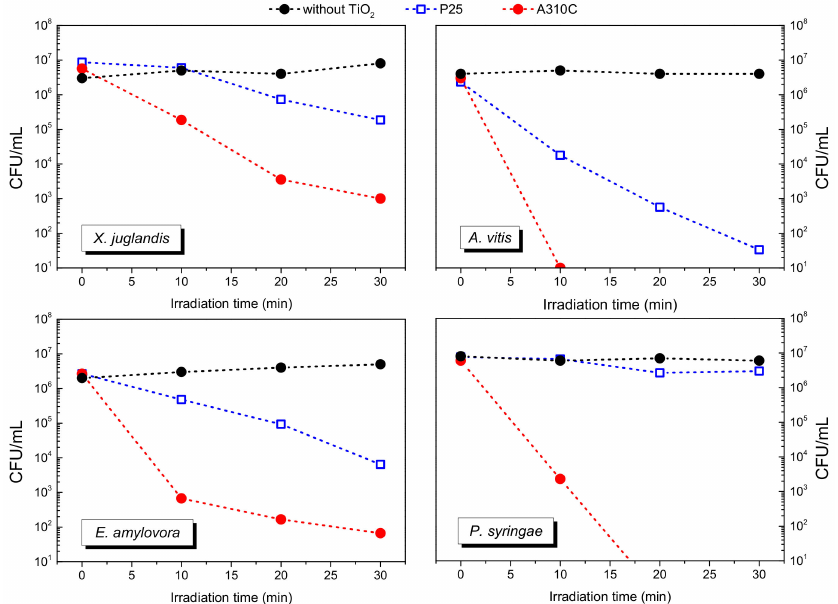
Figure 7. Antibacterial activity of A310C and P25 TiO 2 photocatalysts against Xanthomonas arboricola pv. juglandis , Allorhizobium vitis , Erwinia amylovora , and Pseudomonas syringae under UV-A irradiation. The concentration of aqueous TiO 2 dispersions was 0.5 mg / mL. Before UV-A irradiation, dispersions containing bacteria were kept in the dark for 15